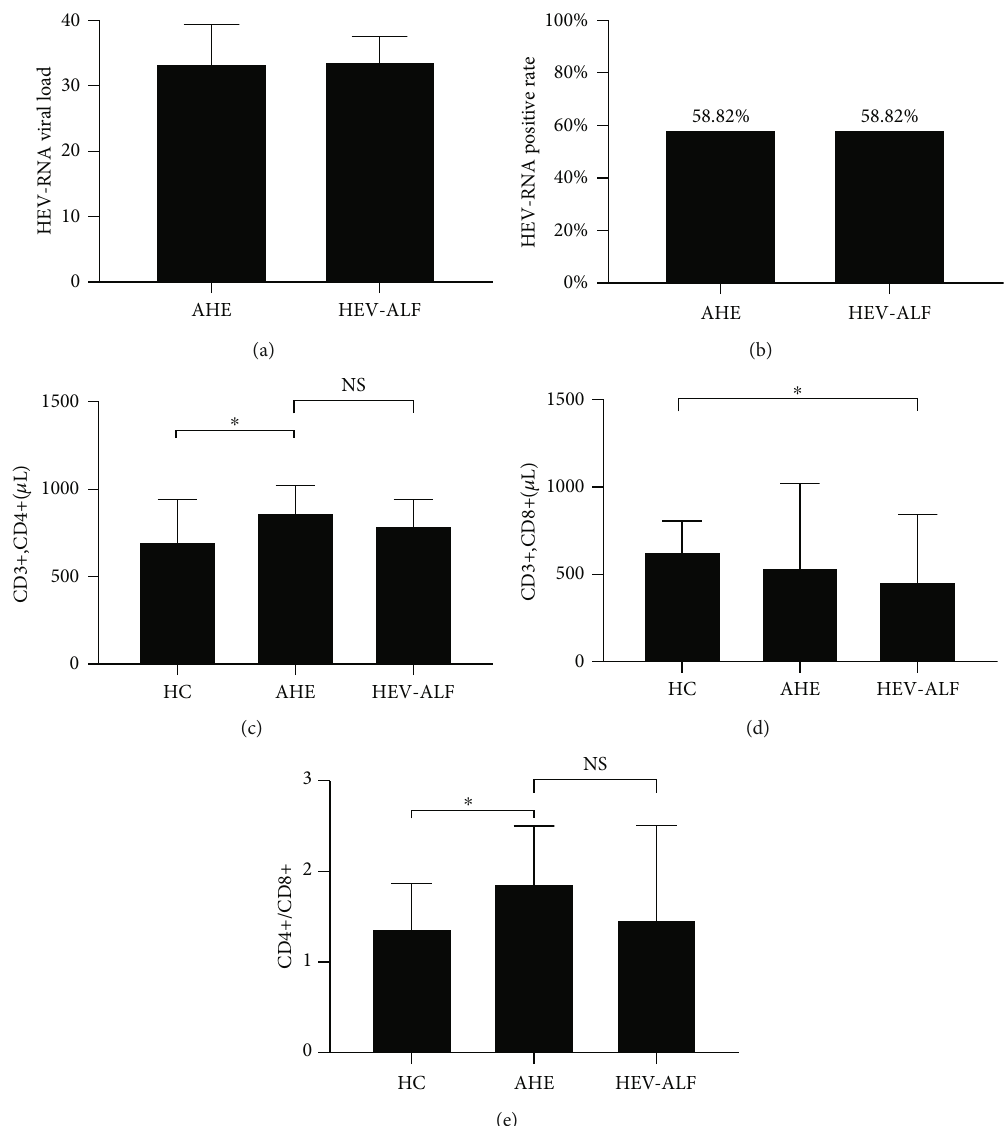
Figure 1: Viral load and lymphocyte levels in the AHE group and HEV-ALF group. (a, b) The viral load and positive rates of HEV-RNA in the AHE group and HEV-ALF group. (c – e) The CD3+CD4+, CD3+CD8+, and CD4+/CD8+ among the HC, AHE, and HEV-ALF